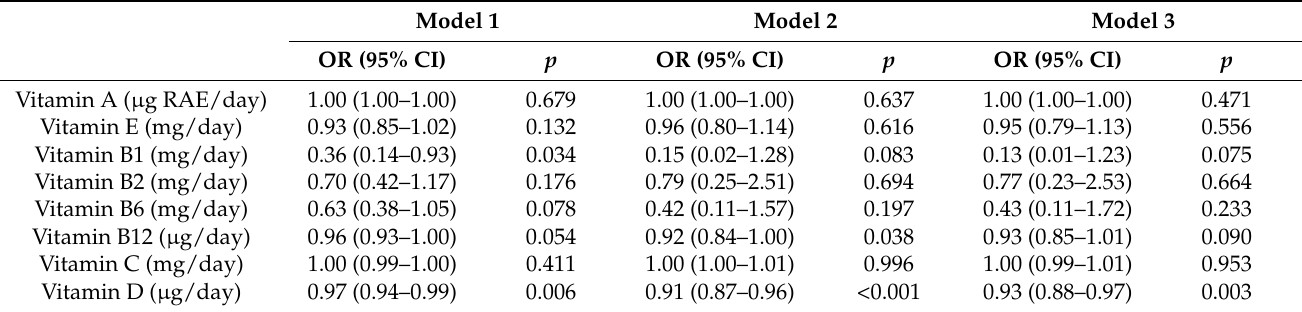
Table 3. Odds ratio of the quantity of vitamin intake on the presence of the loss of muscle